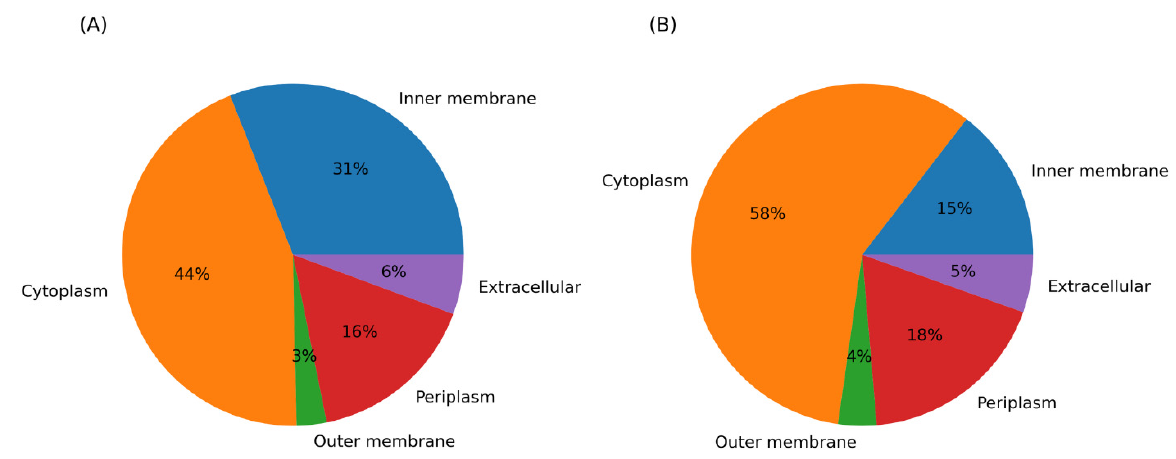
Figure 6. Subcellular protein localization of the proteins of the DEGs, ( A ) proteins of upregulated and ( B ) downregulated genes.